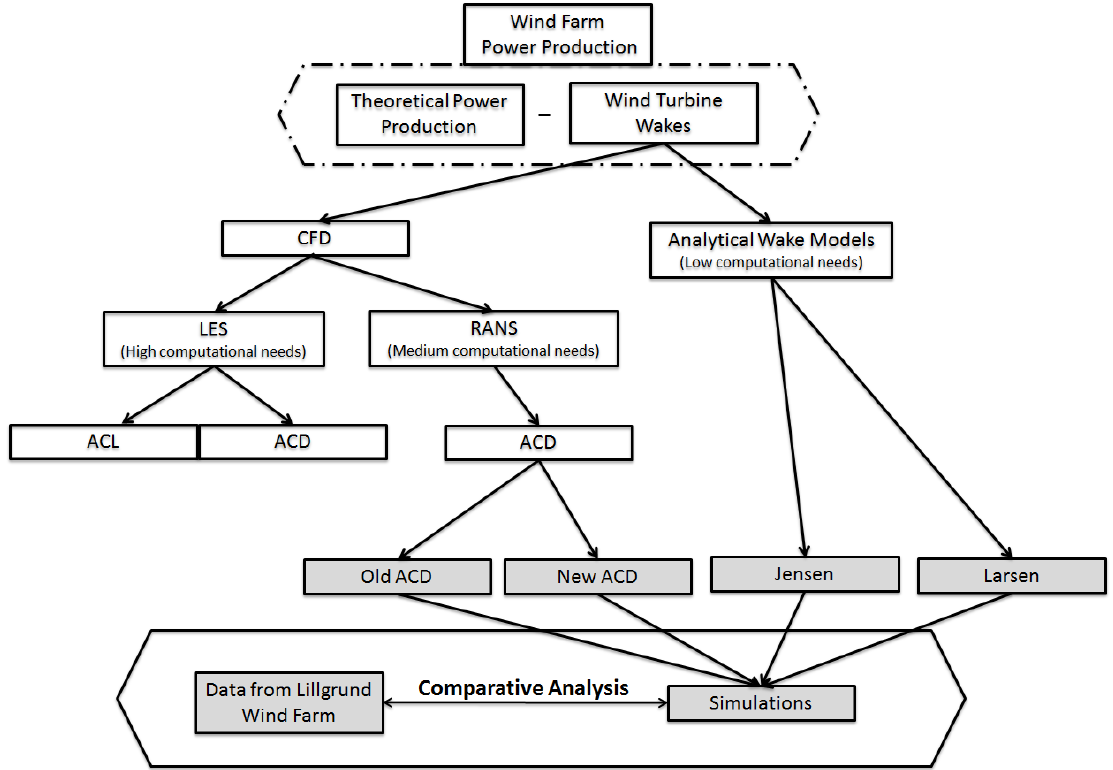
Figure 1. Methodological